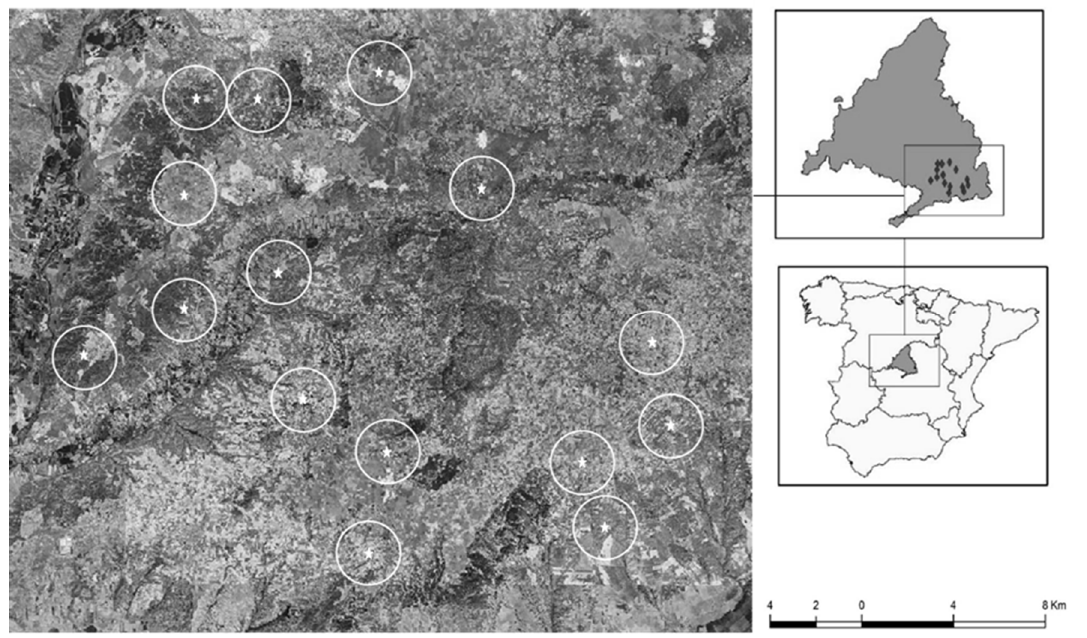
Figure 1. Location and aerial photograph of the study area. Sampled olive groves are indicated with asterisks, as well as the 1500 m radius areas around them.